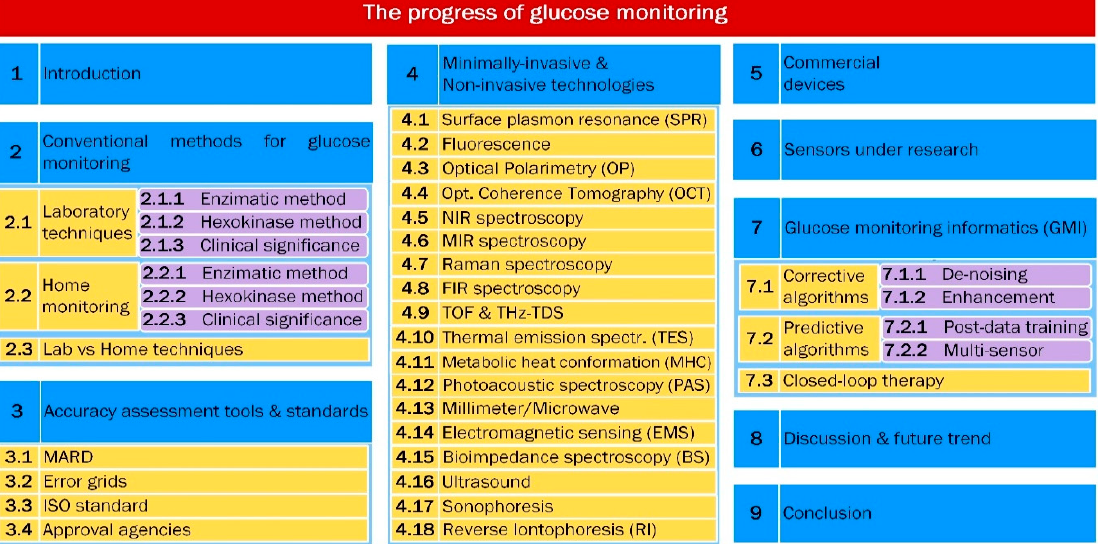
Figure 1. Structure of the paper.